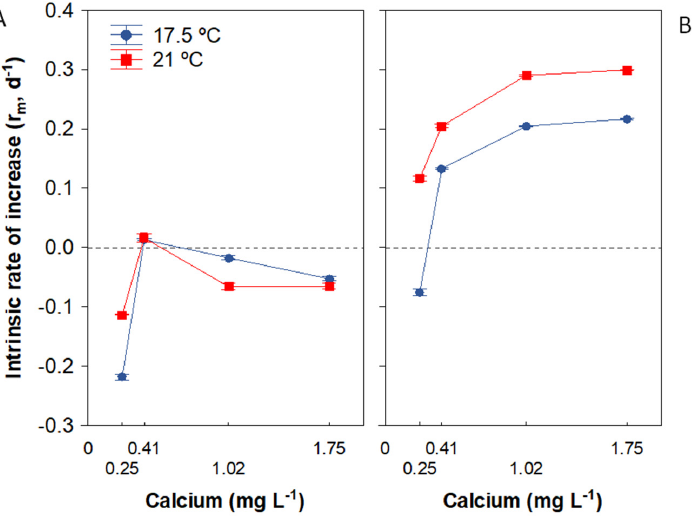
Figure 6. Average population growth rate ( r ) of Daphnia pulex in response to a Ca gradient at two temperatures with low ( A ) or high ( B ) food levels. Data represent mean ± SE. Note that error bars bars are smaller than data points in some cases. are smaller than data points in some cases .